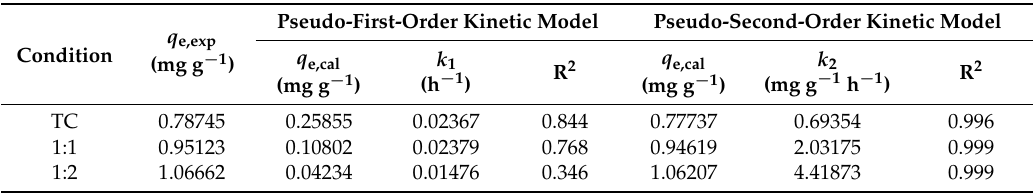
Figure 5. Adsorption kinetic curves of TC with or without Cu(II) onto water hyacinth roots fitted by ( a ) pseudo-first-order kinetic model ( b ) pseudo-second-order kinetic model Dots: measured data, solid line: curve fitted into the models. Table 1. Kinetic parameters of the pseudo-first-order and pseudo-second-order kinetic models for adsorption of TC onto the roots of water hyacinth with or without Cu(II).